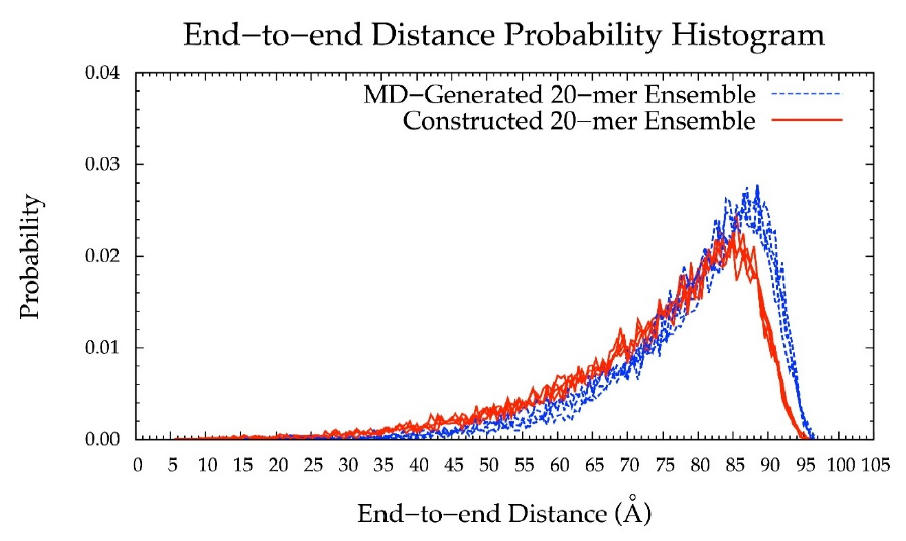
Figure 6. End ‐ to ‐ end distance probability distribution of MD ‐ generated (blue dashed lines) and constructed (red solid lines) 20-mer ensembles; each type of ensemble includes four sets of 10,000 constructed (red solid lines) 20 ‐ mer ensembles; each type of ensemble includes four sets of 10,000 conformations; probabilities were calculated for end-to-end distances sorted into 0.5 Å conformations; probabilities were calculated for end ‐ to ‐ end distances sorted into 0.5 Å bins.